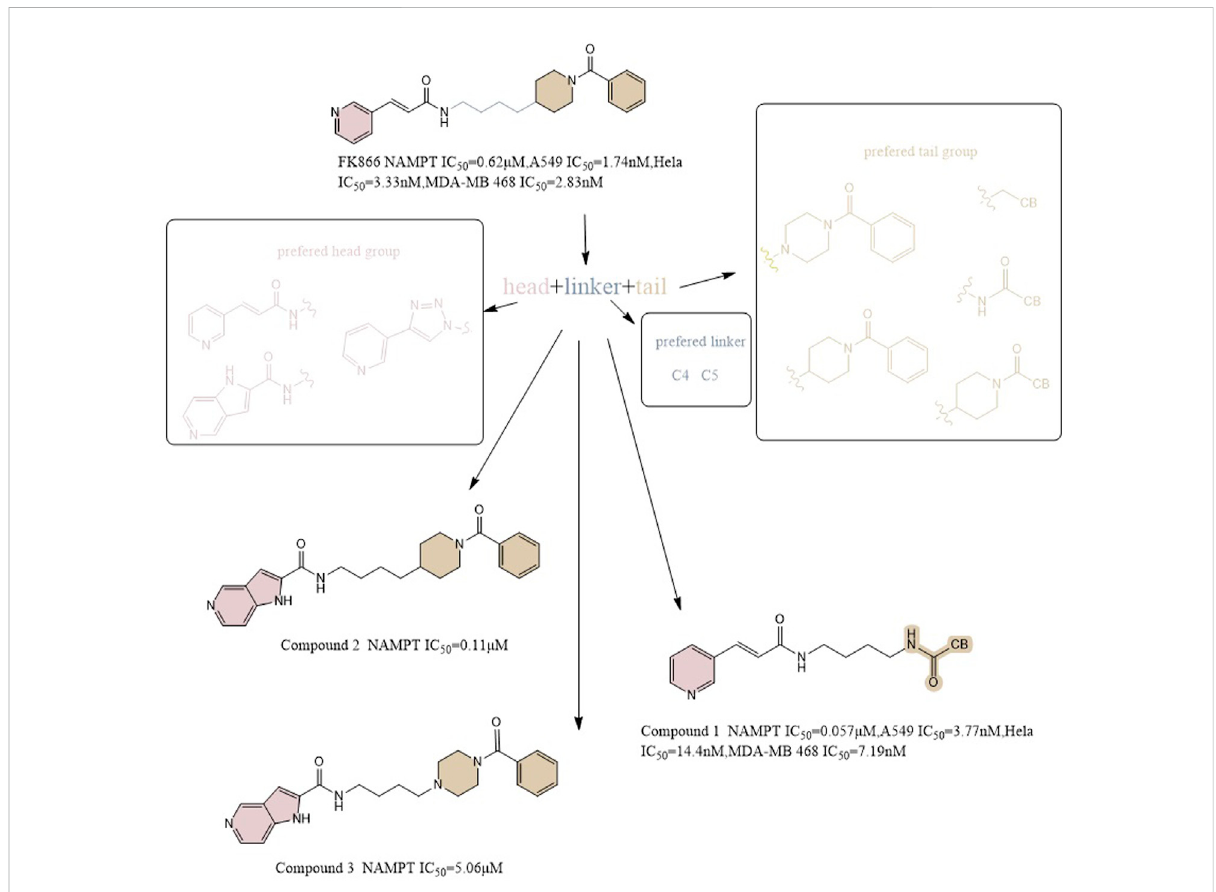
FIGURE 4 Structural optimization of NAMPT inhibitors based on FK866 as a